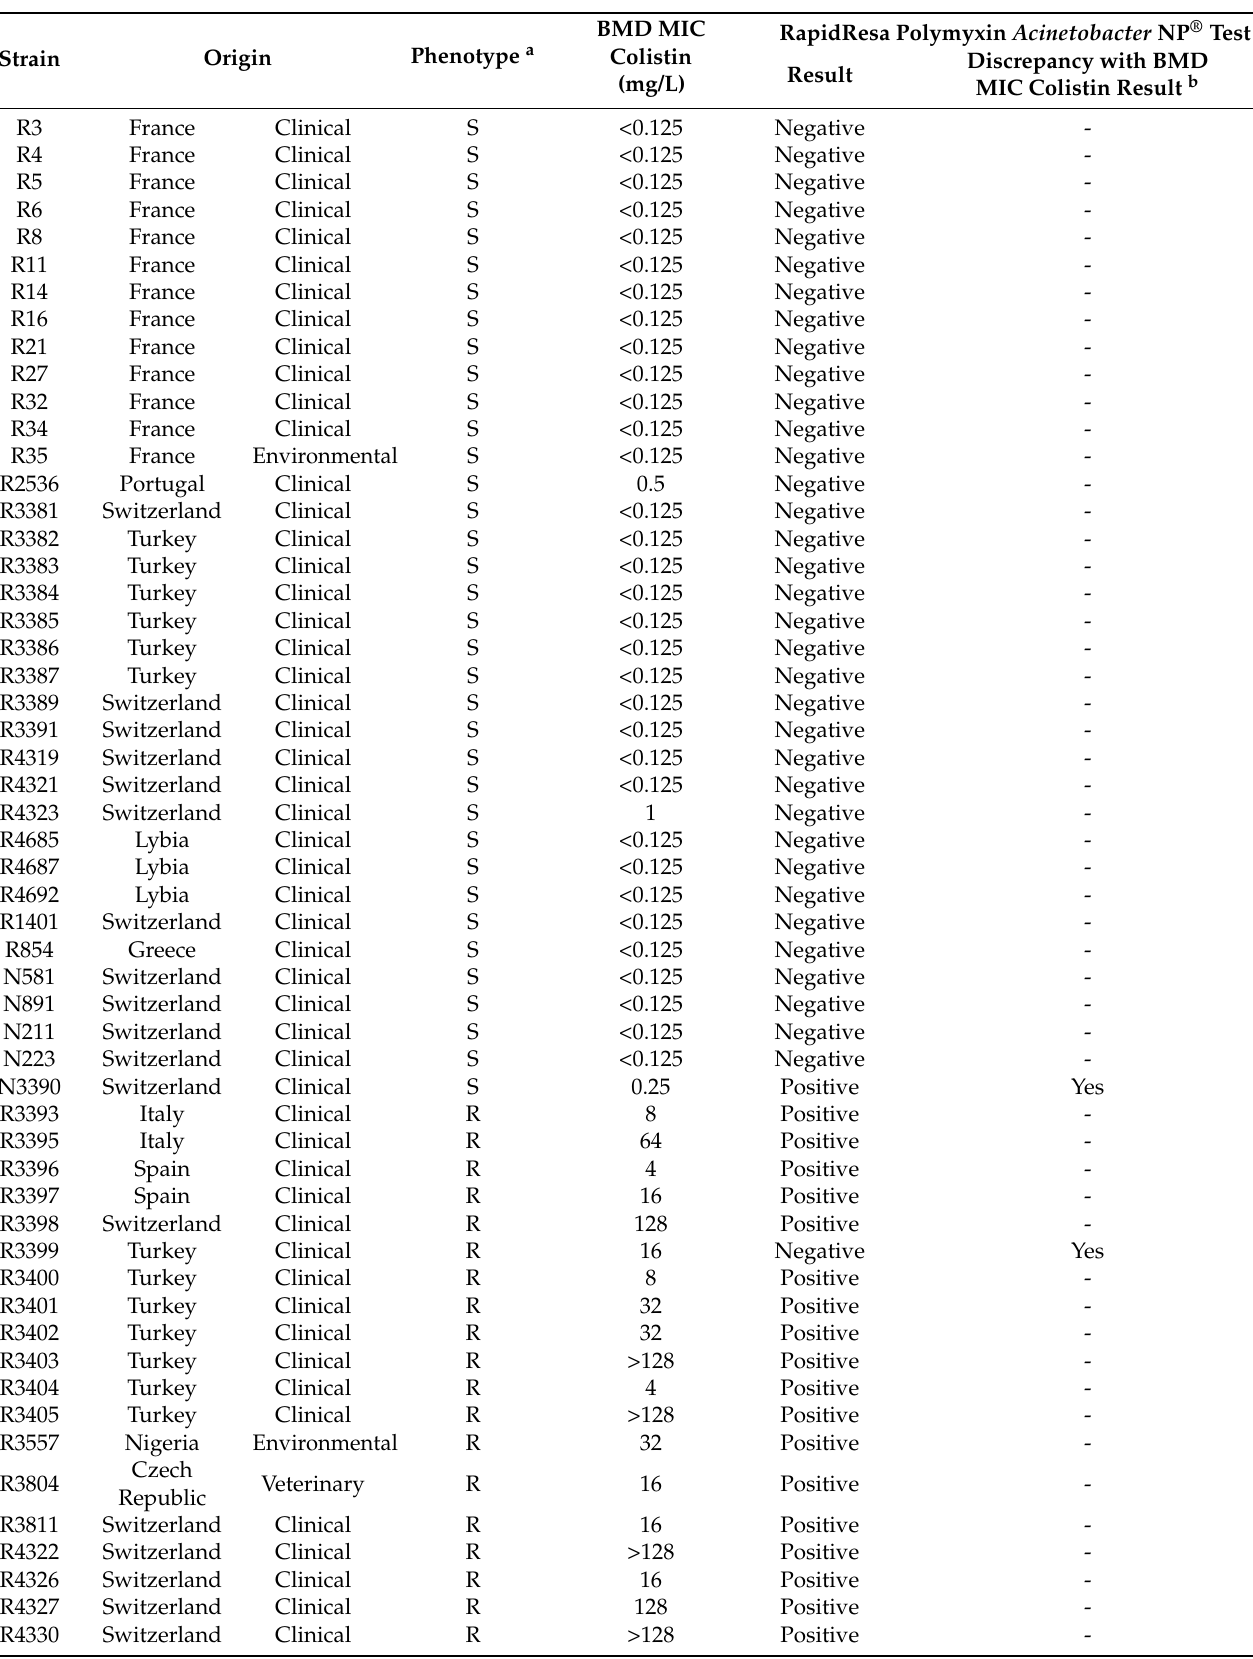
Table 1. RapidResa Polymyxin Acinetobacter NP ® test for rapid detection of polymyxin resistance in A. baumannii isolates.